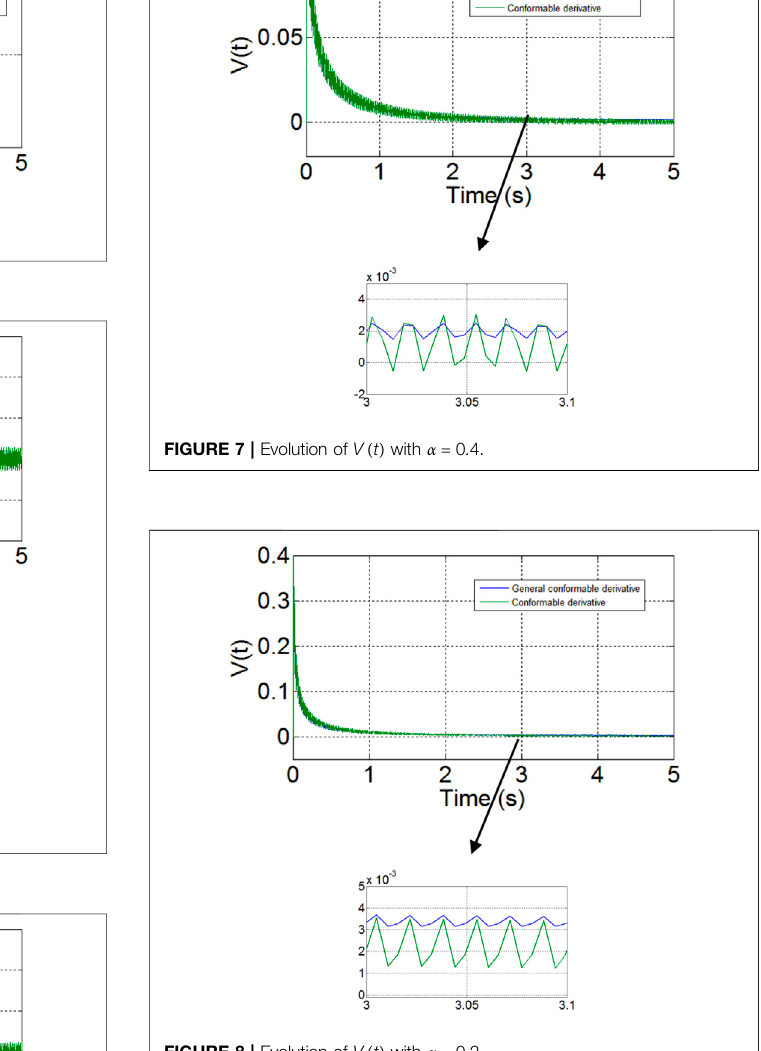
FIGURE 8 | Evolution of V ( t ) with α (cid:2) 0 .